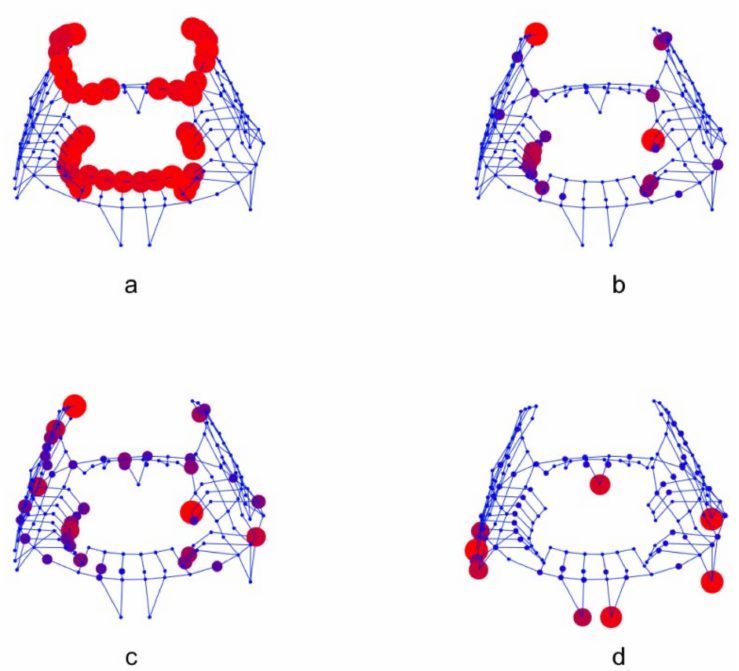
Figure 7. Distribution of people at different times during the evacuation process of 25,000 people.